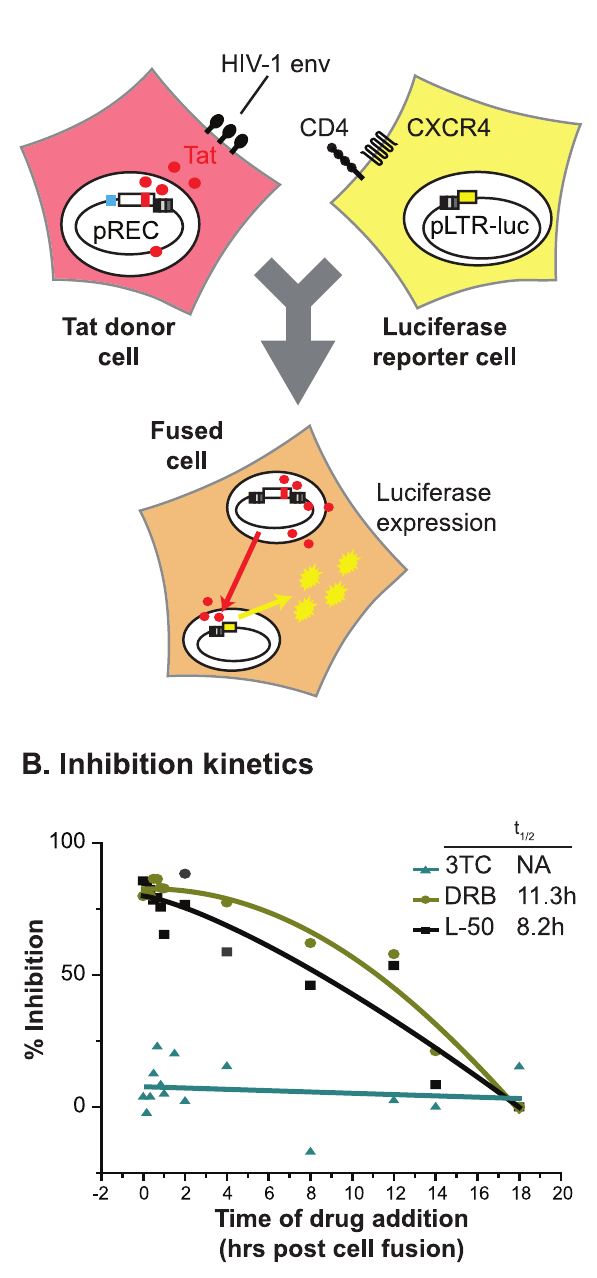
Figure 6. Time-of-drug-addition experiments during synchro- nized cell-to-cell fusion. ( A ) A cell-to-cell fusion was mediated by an effector 293T cell, expressing HIV-1 Env gp120/gp41 (via pREC nfl transfection), binding to CD4 and CXCR4 receptors on a target U87 cell.